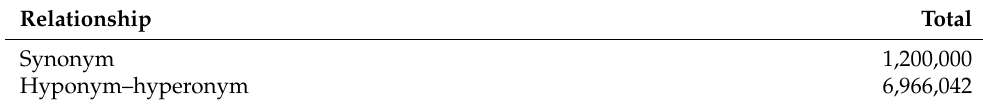
Table 3. Semantic relationships